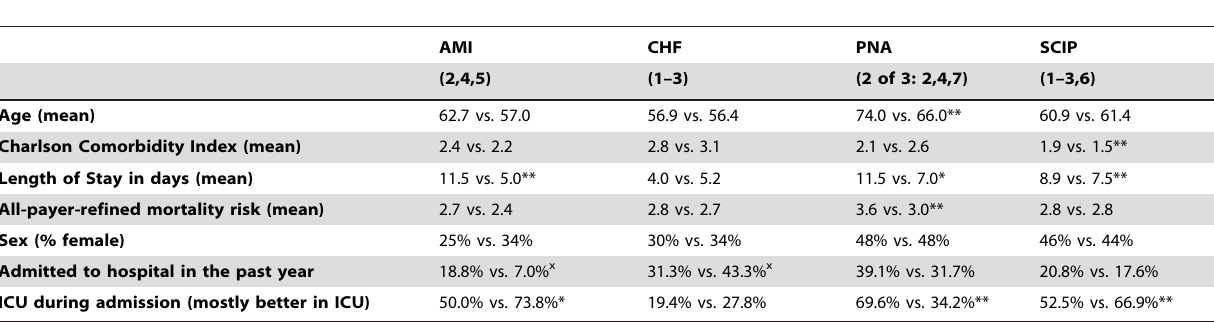
Table 2. Bivariable analysis for each independent variable and the outcome of 100% adherence with each CMS process-of-care composite measure comparing patients without 100% adherence with composite measures to those patients with 100% adherence to composite measures [19,20].